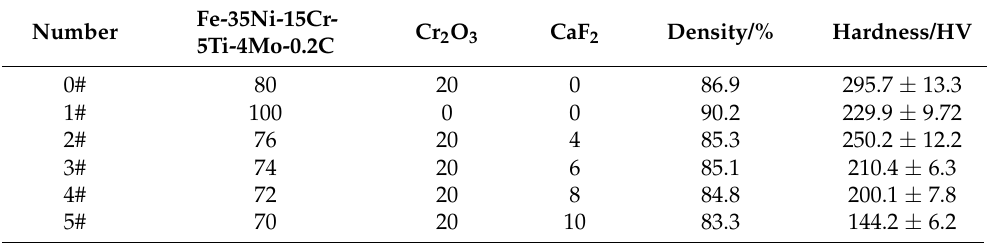
Table 1. Compositions of 35Ni15Cr Fe-based self-lubricating die sample. (wt%).